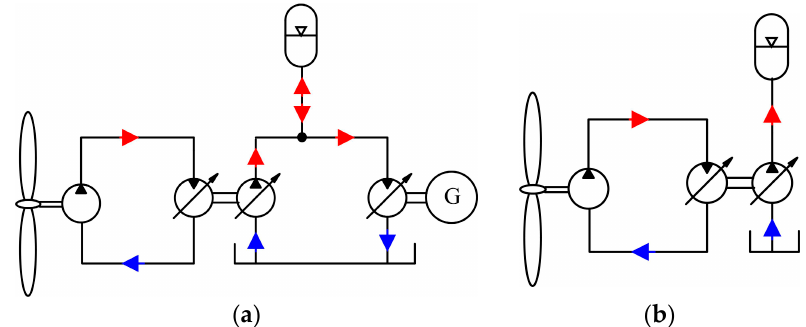
Figure 4. ( a ) The oil flow direction in the electric power generation model; ( b ) The oil flow direction in the wind energy storage